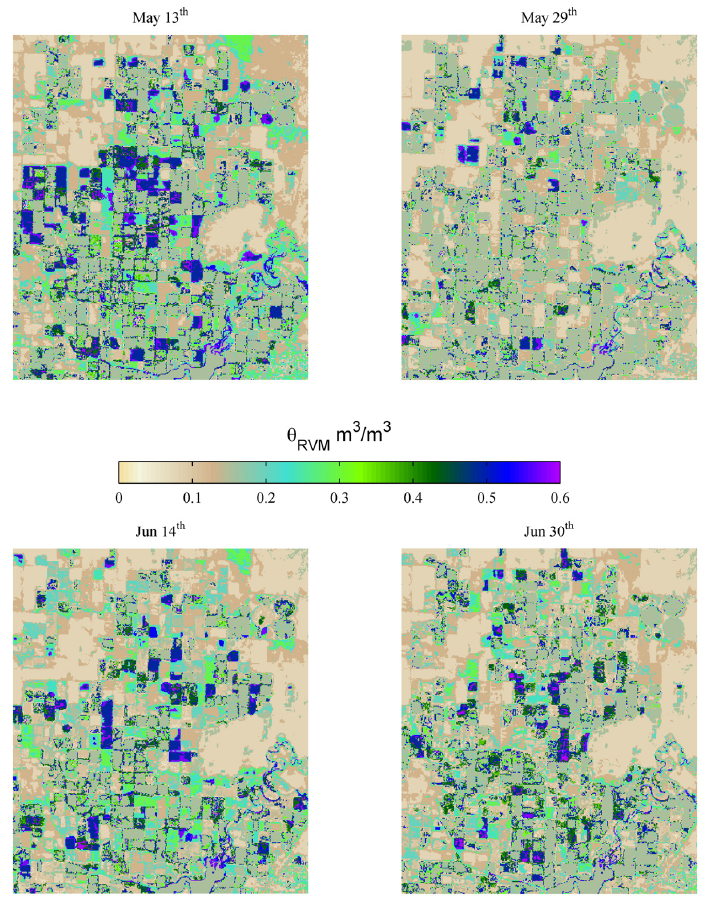
Figure 7. Spatial Estimation of Surface Soil Moisture for the four Landsat 7 ETM+ dates using the RVM model with the bubble kernelkernel. Note: Soil moisture values higher than 0.5 m 3 /m 3 indicate fields under irrigation.